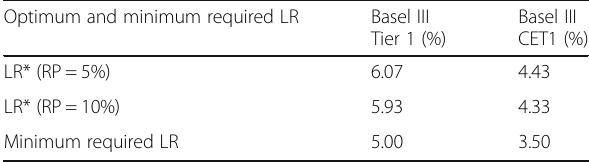
Table 6 Base case: optimal TBTF leverage ratios for Swiss